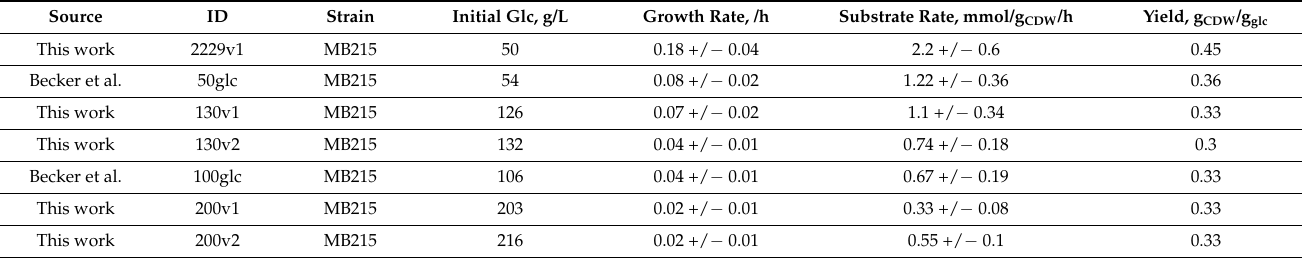
Table 3. Glucose batch growth experiments were performed and used from the literature [4]. The data provided growth and substrate uptake rates for testing iUma22 predictions. Growth results for each experiment is provided in the